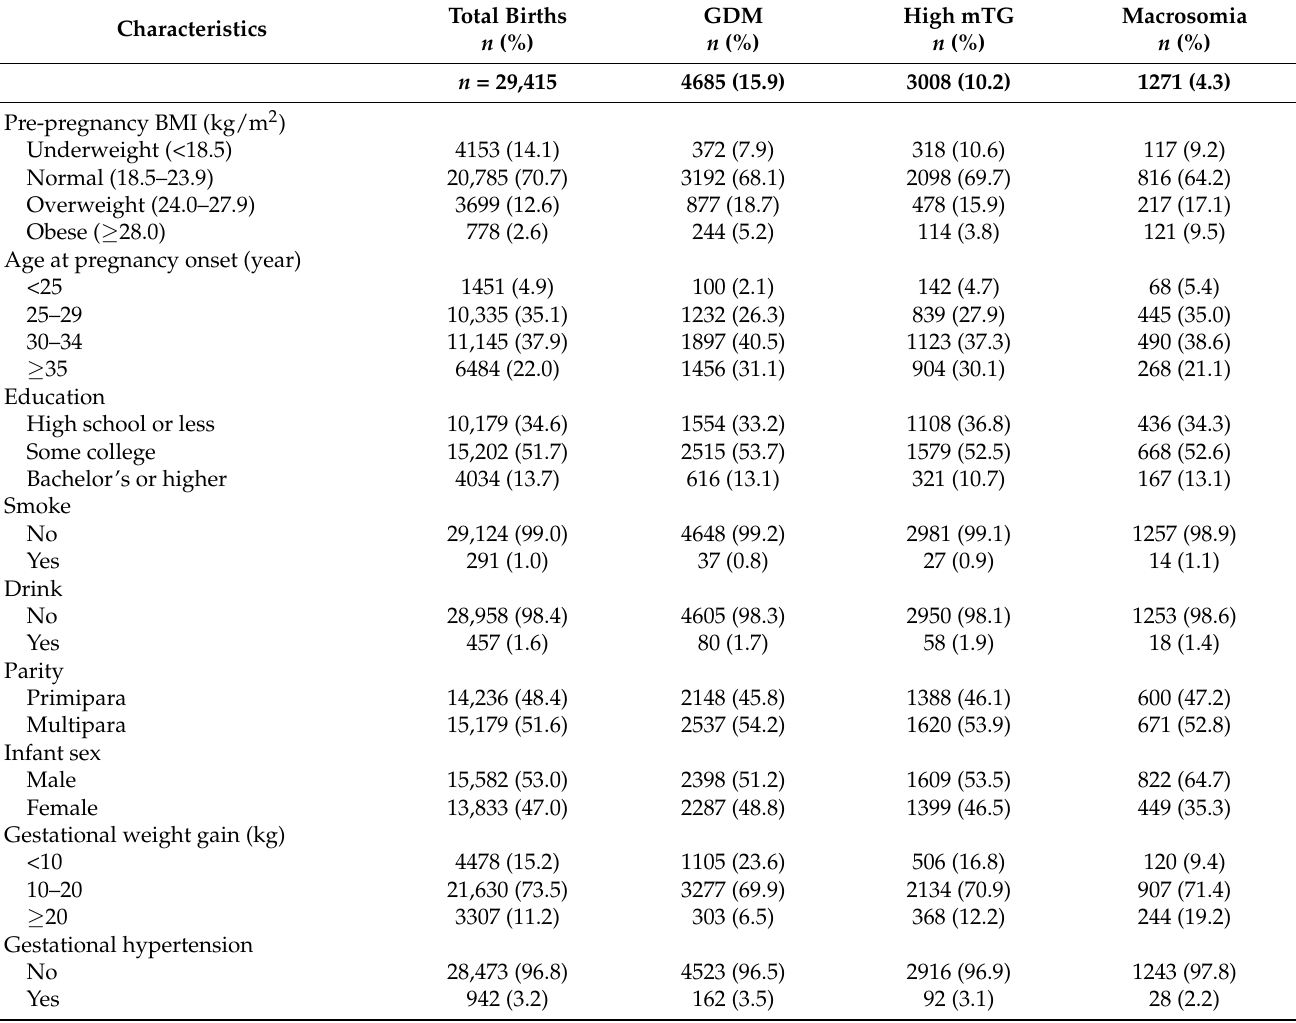
Table 1. Maternal and newborn characteristics were distributed in the high mTG levels, GDM and macrosomia